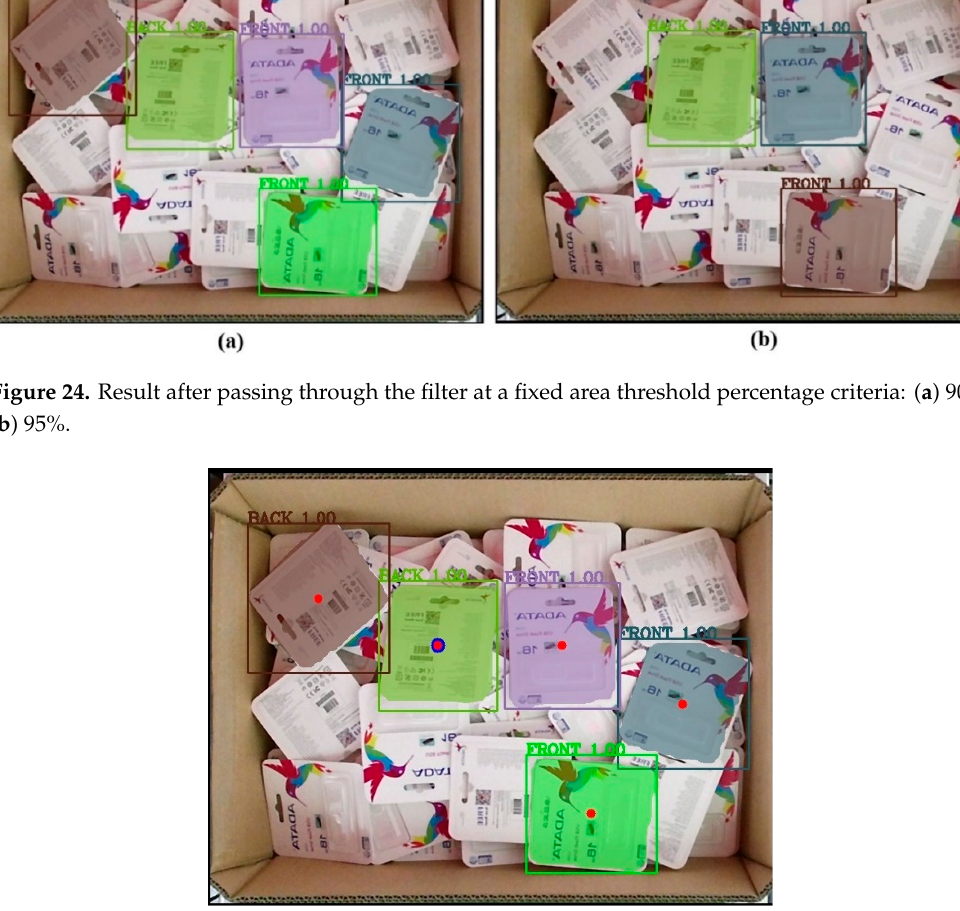
Figure 25. Result after calculating the center points (red points) and deciding the final target (blue point).